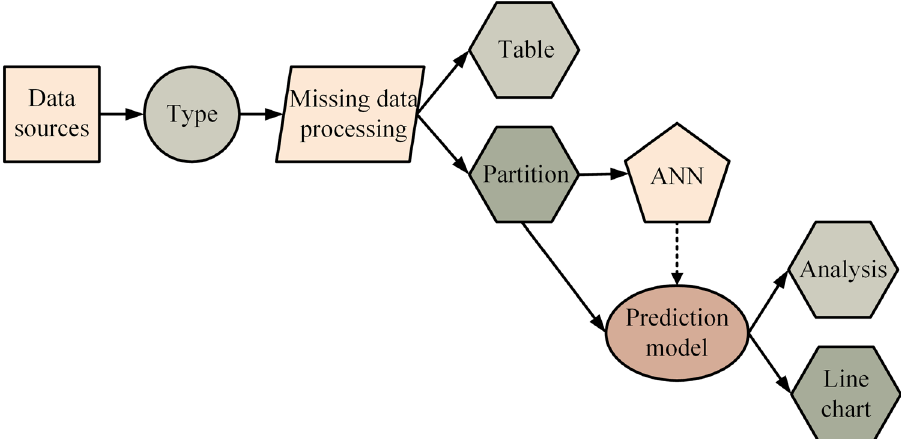
Fig. 3 Prediction model of in fl uencing factors of construction enterprises ’ adoption of green development behaviors. This paper completes data import, variable setting, missing value processing and model construction